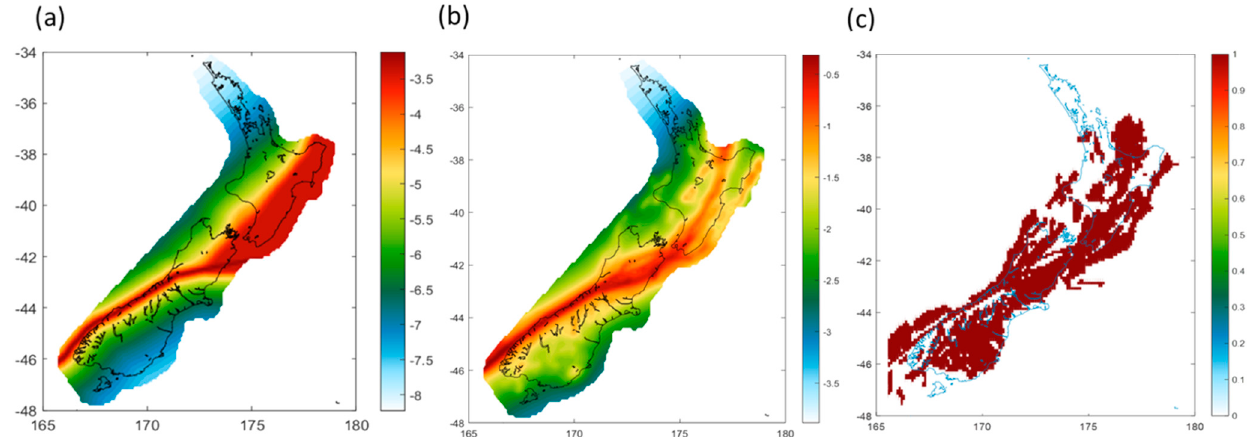
Figure 1. Spatial distributions of the modified ( a ) Proximity to plate interface (PPI) and ( b ) Proximity to mapped faults (PMF) covariates (log of grid cell values). The colour scale shows the logarithm of the relative rate. ( c ) Spatial distribution of updated Fault in cell (FLT) binary covariate using all faults from the New Zealand Community Fault Model [18].